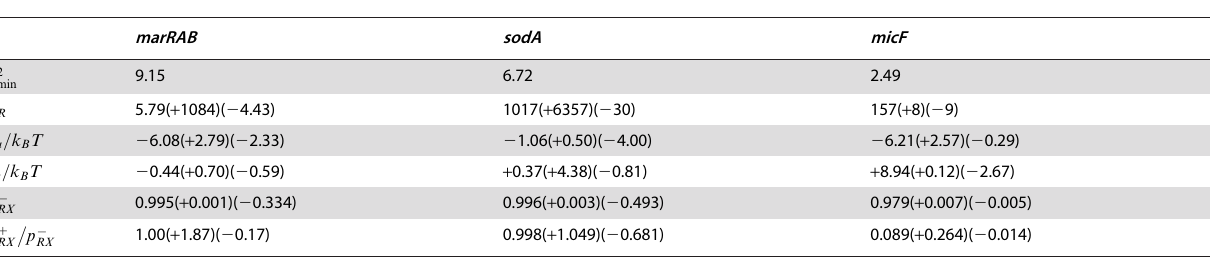
Table 2. Properties of models with the lowest value of x 2 .